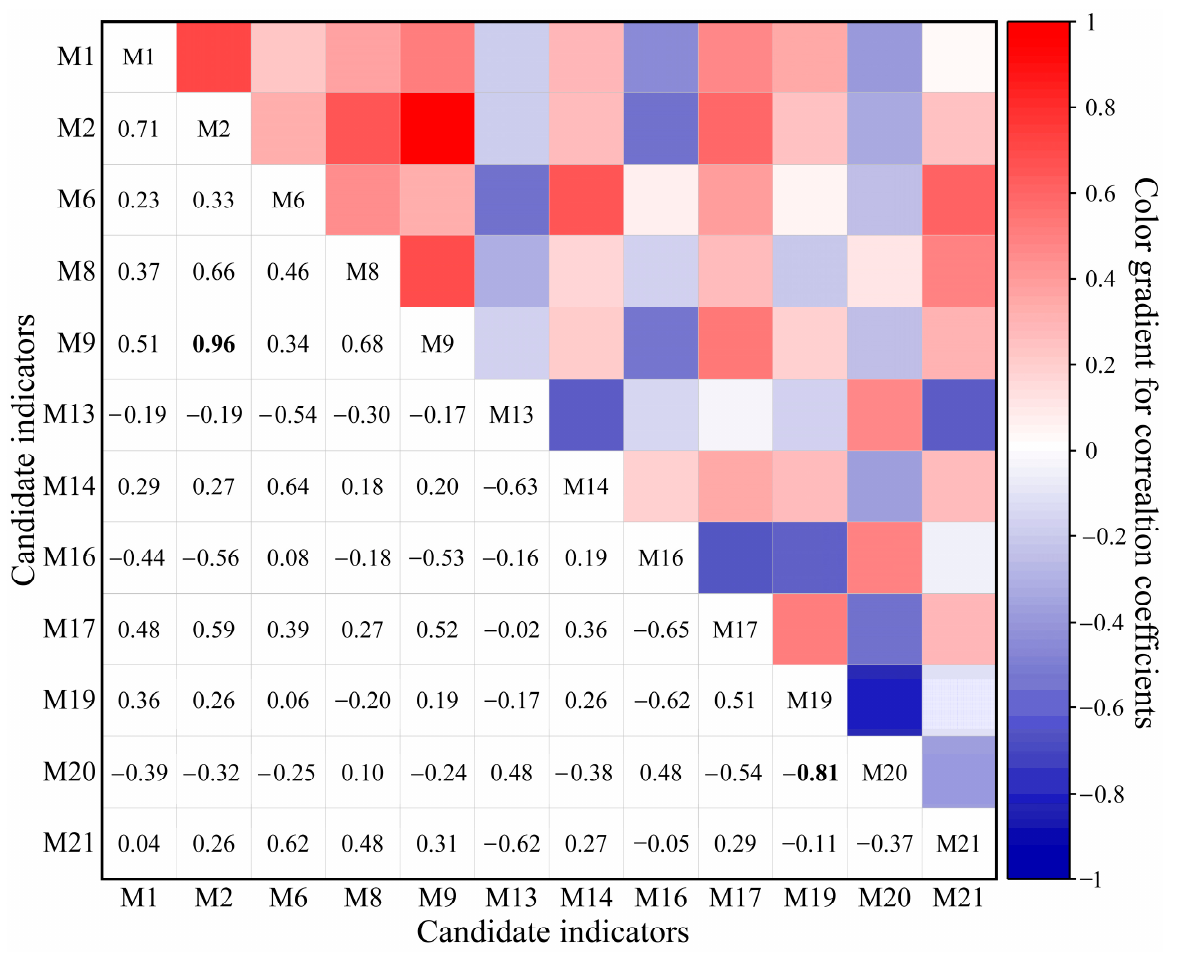
Figure 7. Box plots of the 12 candidate metrics between the reference sites (R) and the disturbed sites (D).